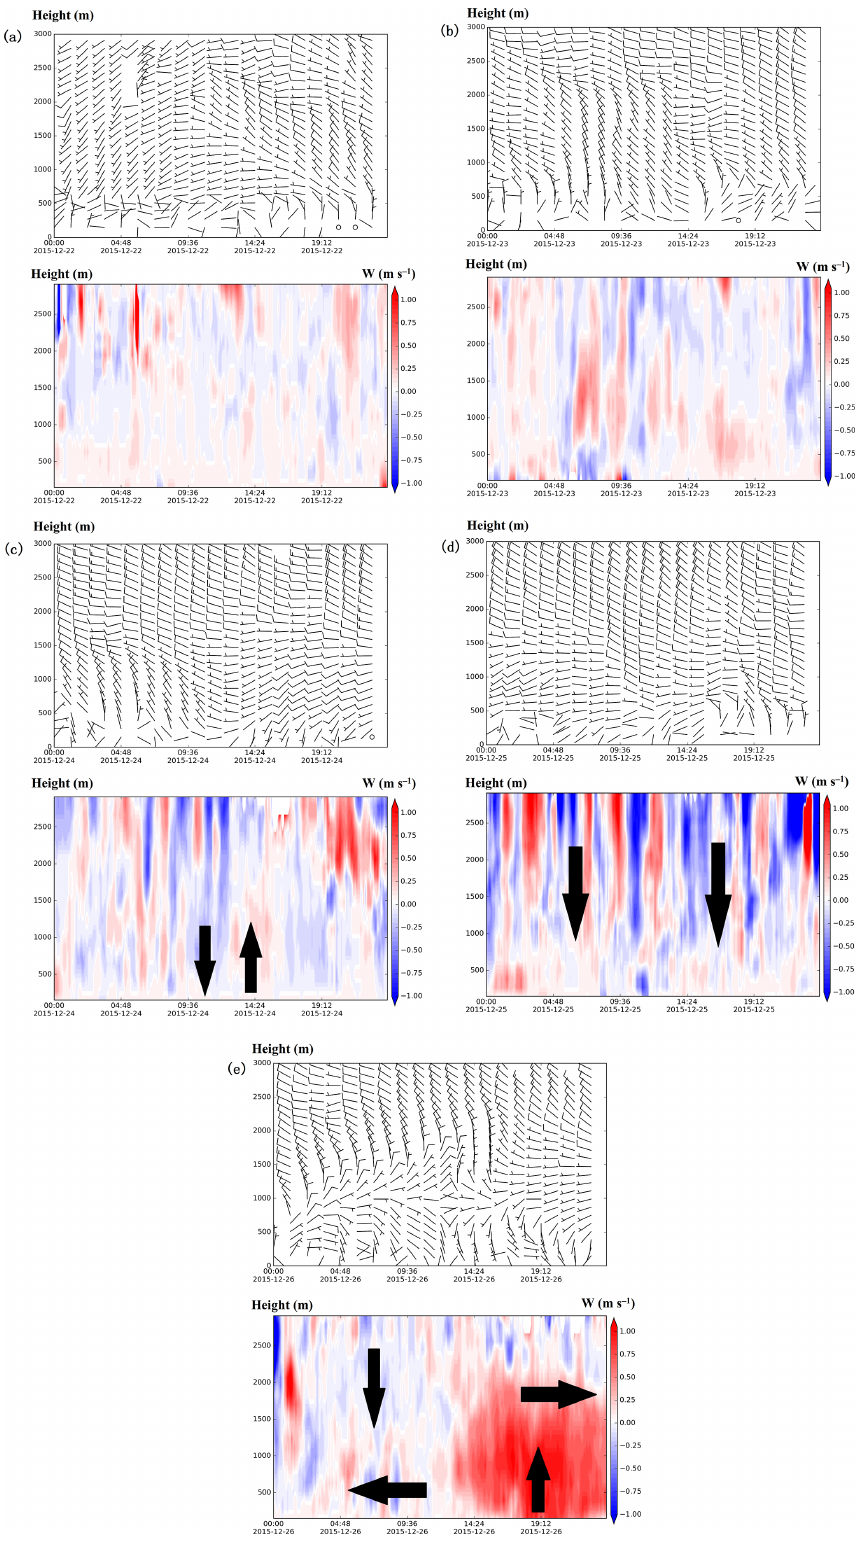
Figure 13. The horizontal and vertical wind field characteristics in the Beijing observatory (39.93 ◦ N, 116.28 ◦ E) from 22 to 26 December 2015 ( a–e , above is the horizontal wind field, below is the vertical wind speed (W), wind speed is in ms − 1 , and the red shadow represents the upward movement; blue represents the sinking movement; the x axis is in Beijing time; the y axis is the height in meters). Atmos. Chem. Phys., 21, 8863–8882,